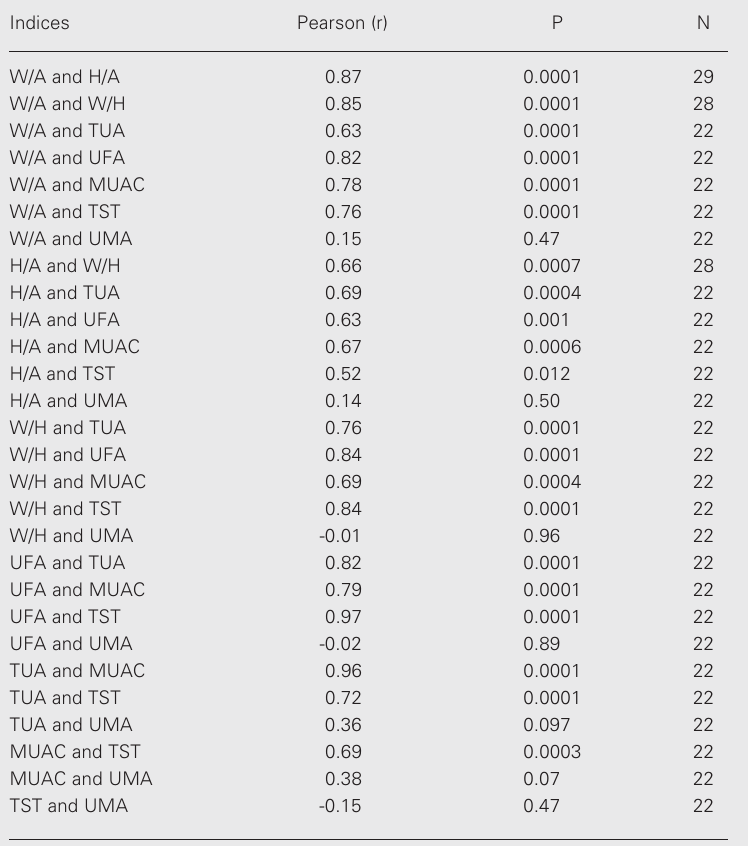
Table 2. Pearson’s correlation coefficients for anthropometric measurements and